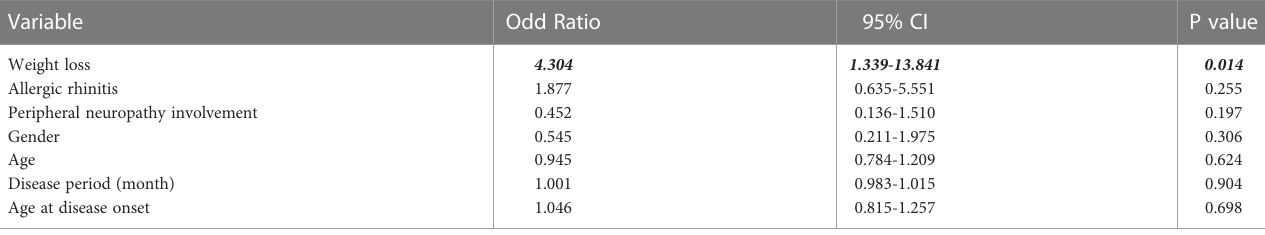
TABLE 4 Multivariate analysis for 21 EGPA patients with GI involvement and 73 controls. Variable Odd